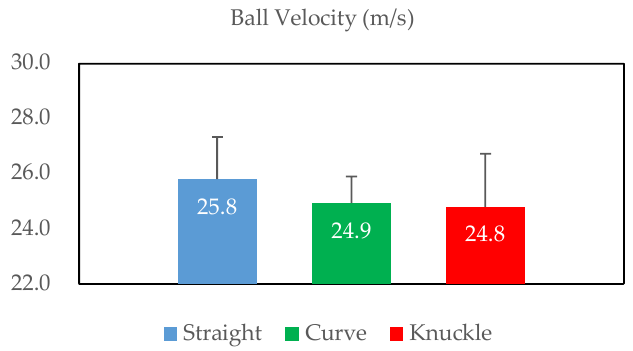
Figure 3. Ball velocity values of each trial. There are no significant differences between each